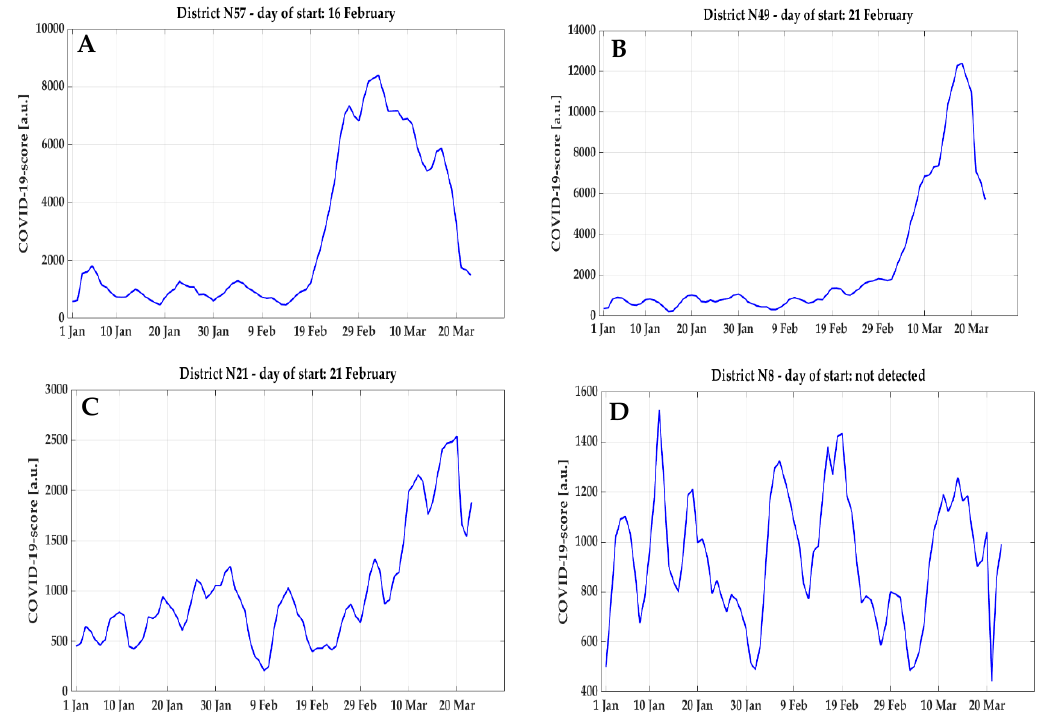
Figure 6. Representative morphologies of the computed time-series of COVID-19 score (a-dimensional unit) for different clusters, defined into four classes: class 1 ( A ), very sharp and evident raising curve; class 2 ( B ), evident but smoother raising curve; class 3 ( C ), detectable but smaller raising curve (implying a lower signal-to-noise ratio); class 4 ( D ), raising curve not clearly detected. Different ranges in the y -axis are used to enhance the visualization of the different morphologies.